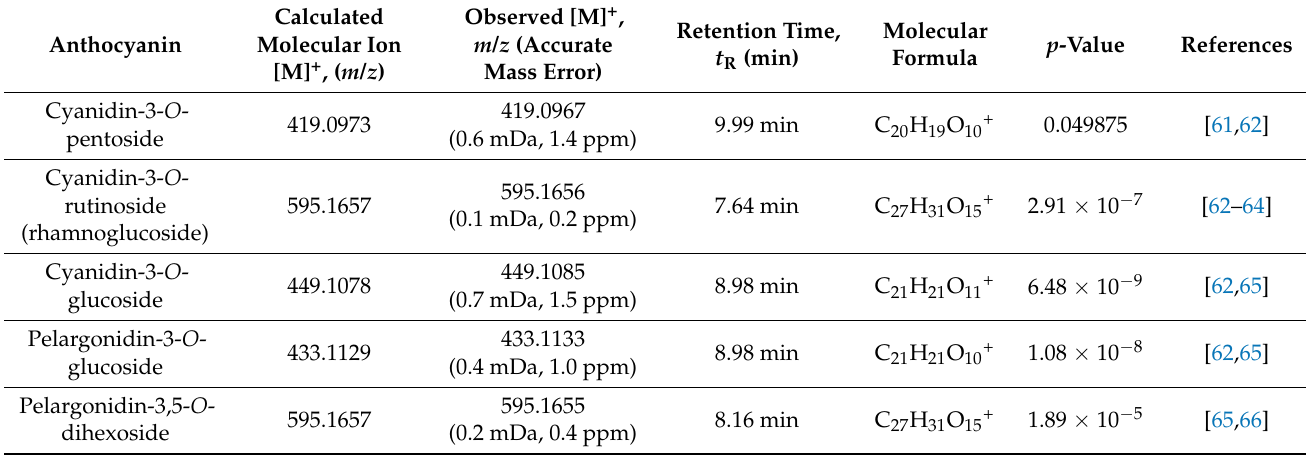
Table 5. Anthocyanins detected in C. caudatus